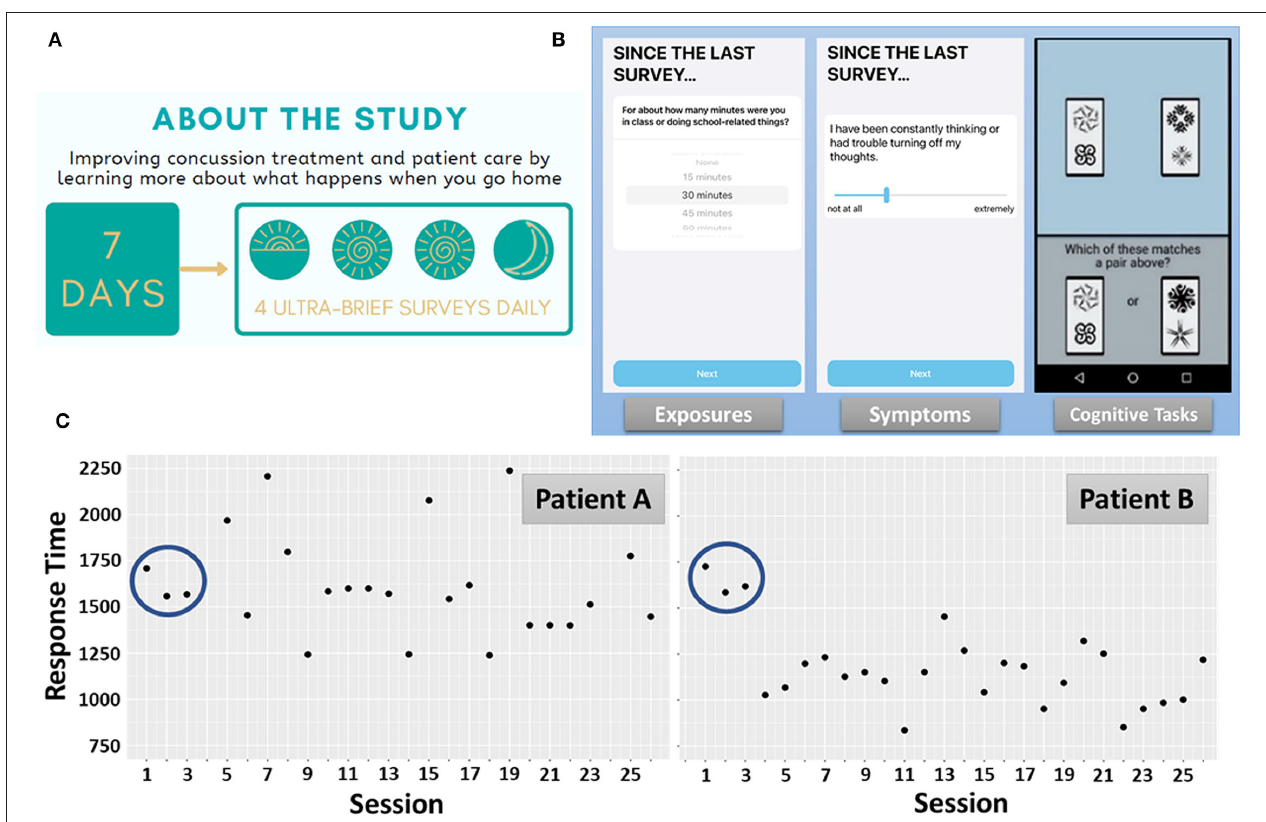
FIGURE 1 | MNCH Study Protocol. (A) Recruitment study infographic depicting the measurement burst design. (B) Each assessment contained short surveys of various environmental exposures, symptom severity ratings, and performance-based cognitive tasks. The Symbol Search task, measuring processing speed and attention, is depicted. (C) Response time profiles during Symbol Search performance over the 7-day measurement burst. Patient A and Patient B exhibit nearly identical response times during the first 3 administrations of the Symbol Search task. Thereafter, Patient A exhibits high intra-individual variation and generally no improvement in task performance over 7 days. Patient B, by comparison, exhibits exponential improvement early in the measurement burst, lower intra-individual variation, and evidence of incremental improvements throughout the measurement